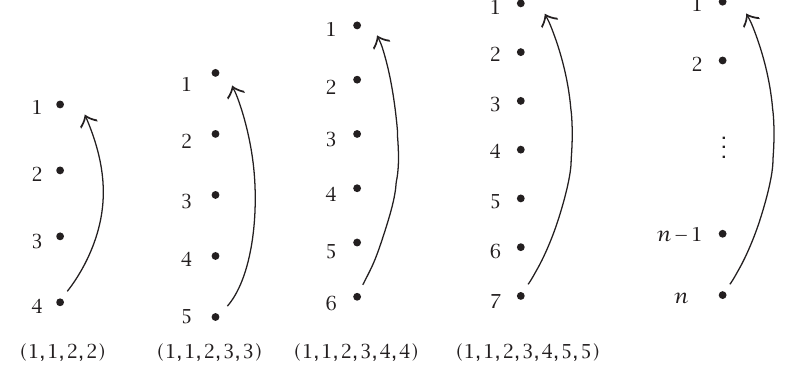
Figure 4.1 Tournaments of the family for k =